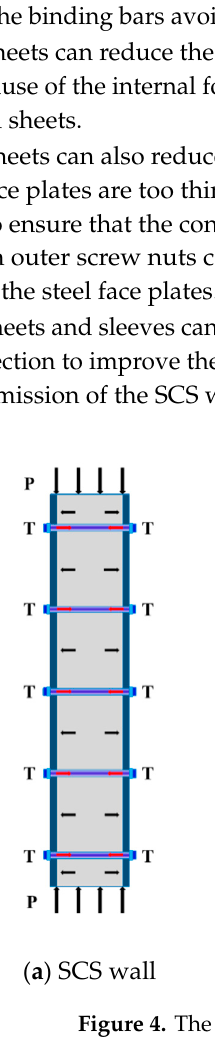
Figure 3. Main types of connectors used in steel-concrete-steel (SCS) composite walls.